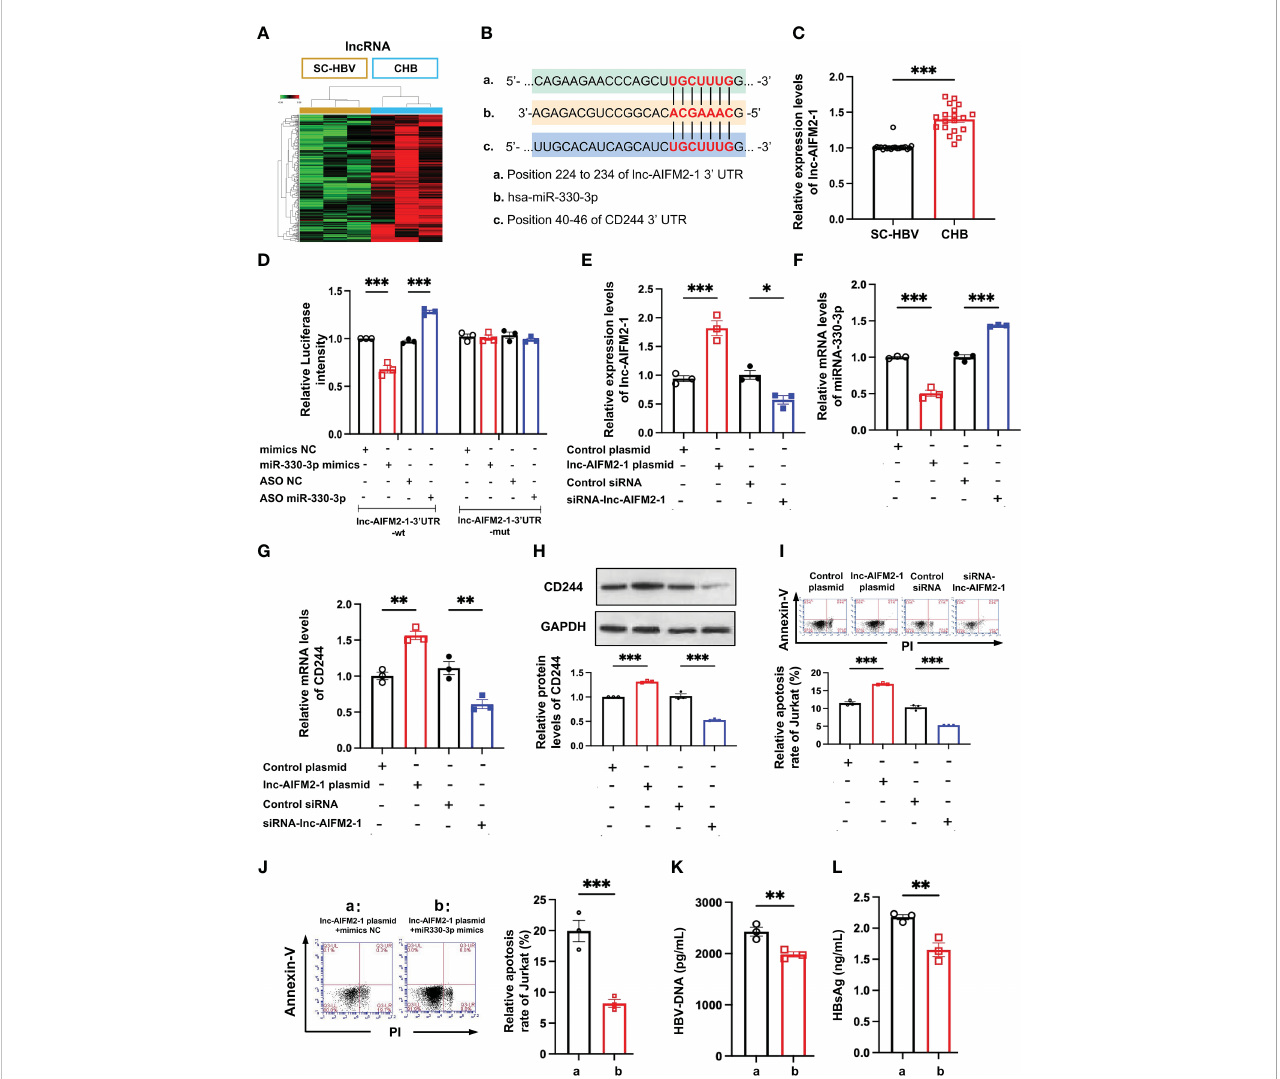
FIGURE 5 The interaction between lnc-AIFM2-1 and miR-330-3p regulated the immune response. (A) Heat map of up-regulated lncRNAs in CHB (n = 3) patients compared with SC HBV (n = 3) controls. Screening criteria were as follows: P ≤ 0.05 for lncRNAs. Expression values are depicted in line with the color scale; intensity increases from green to red. (B) The prediction interaction sites of CD244 with miR-330-3p and lnc-AIFM2-1. (C) RT-PCR analysis of lnc- AIFM2-1 expression in CHB (n = 18) and SC HBV (n = 20) patients. (D) The relative luciferase activity in co-culture HepAD38 cells and Jurkat cells transfected with the indicated lnc-AIFM2-1-3 ’ UTR-wt plasmid or indicated lnc-AIFM2-1-3 ’ UTR-mut plasmid after the intervention of miRNA mimics/ASO miR-330-3p or not. (E, F) The expression of lnc-AIFM2-1 (E) and miR-330-3p (F) in co-culture system of LO2 hepatocytes or HBV HepAD38 cells